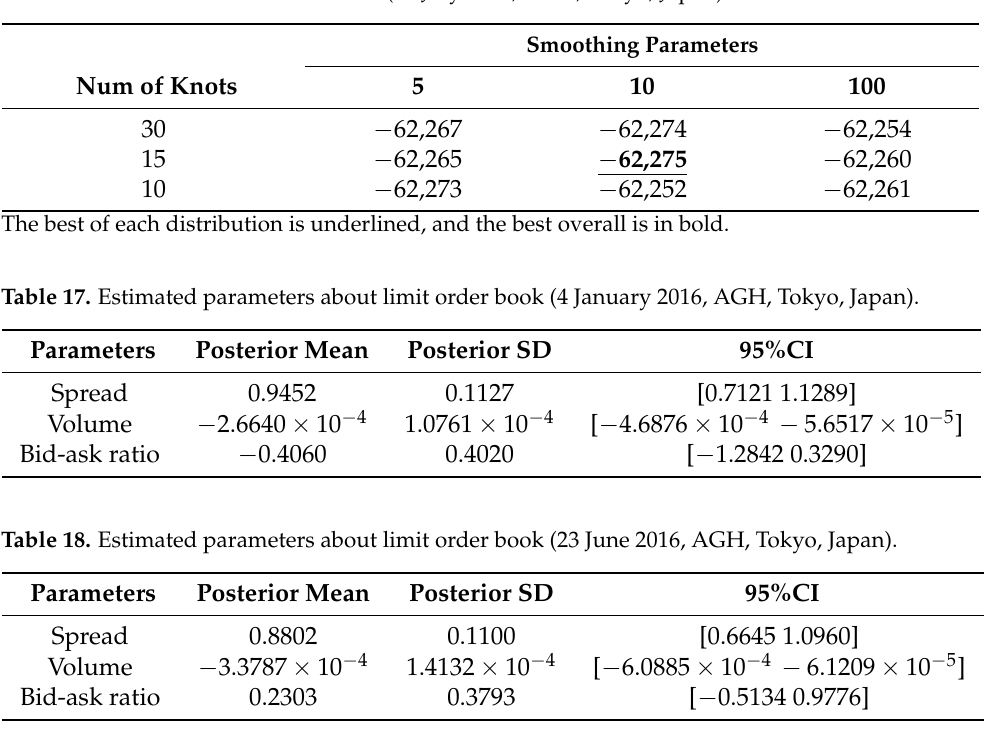
The best of each distribution is underlined, and the best overall is in bold. Table 16. DIC for Gamma distribution (27 July 2016, AGH, Tokyo, Japan).